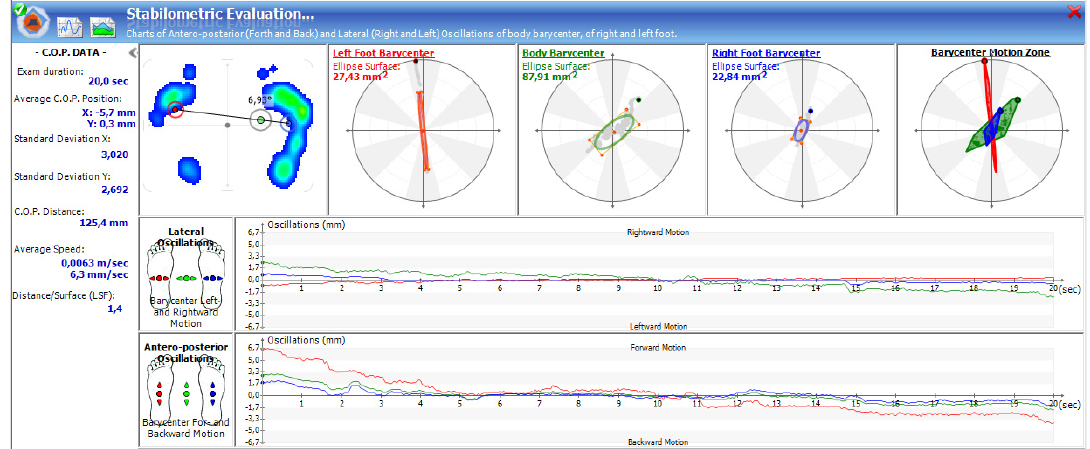
Figure 3. Sample image with the balance results from the Biomech Studio program.